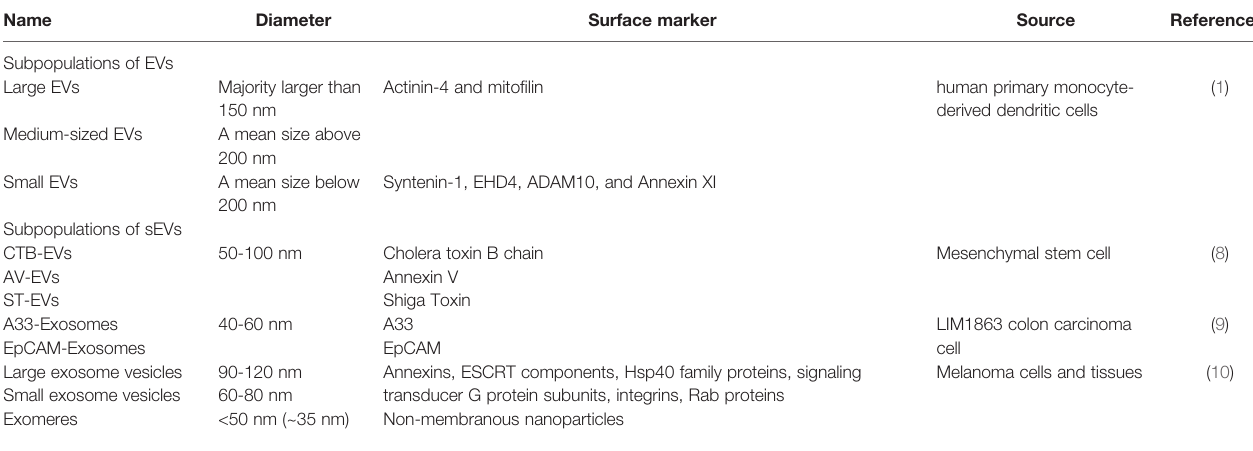
TABLE 1 | Classi fi cation of different extracellular vesicles based on vesicle membrane